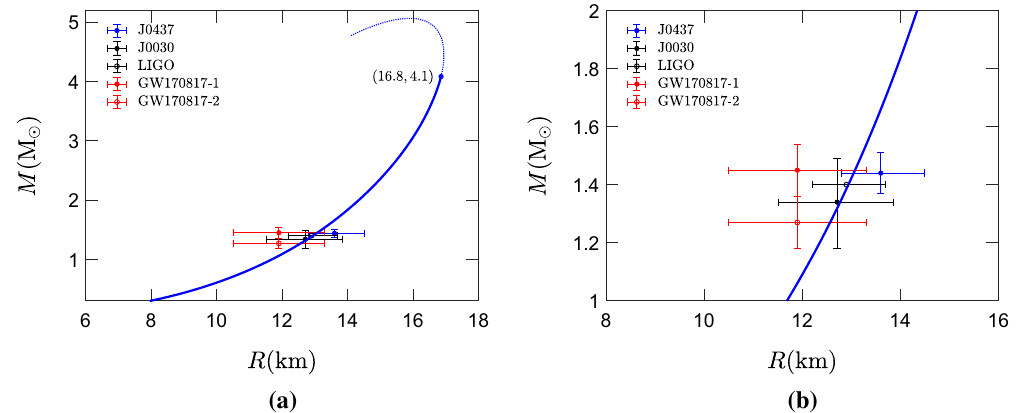
Fig. 8 The curve corresponds to equilibrium solutions with the same boundary condition ρ R = 2 . 7 × 10 14 g / cm 3 . The solid branch corre- sponds to stable, physical solutions and the dotted branch represents unstable or nonphysical solutions. The maximum mass is 4 . 1 M (cid:5) at